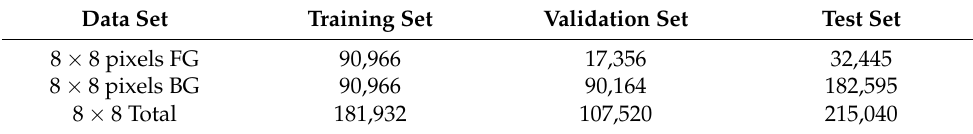
Table 2. Patch-Level data preprocessing. FG (foreground) and BG (background). Data Set